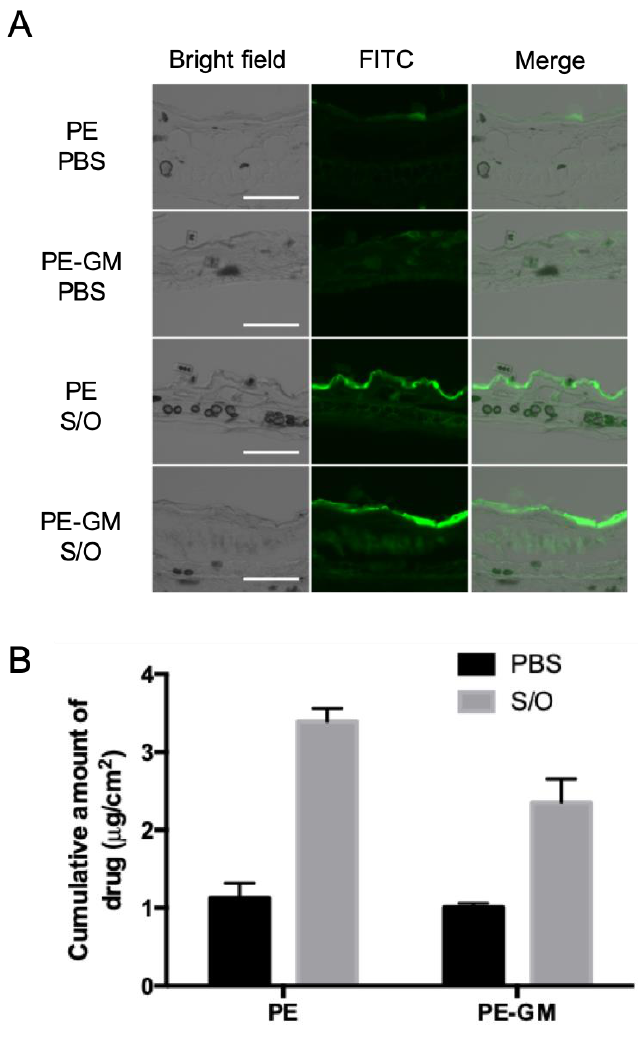
Figure 3. Transcutaneous delivery of antigen to the skin by S/O nanodispersions. ( A ) Skin sectioning fluorescence microscopy images of PE and PE-GM permeating the mouse-ear auricle skin in vivo and ( B ) the cumulative amount of PE and PE-GM in the skin following 6 h incubation in vitro with a PE or PE-GM PBS solution (PBS) and S/O nanodispersions (S/O). Bars: 100 μm. n = 3 – 4, mean ± SE.